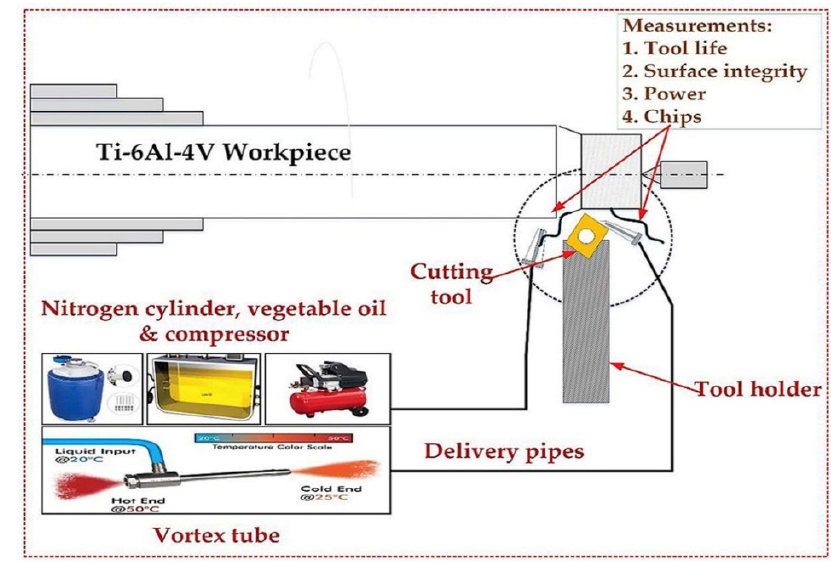
Fig. 23 Mechanism of the performance of hybrid cryo-lubrications in the turning of Ti–6Al–4V alloy in terms of tool wear, surface roughness, and micro hardness [121]. Reproduced with permission from Ref. [121], © Elsevier Ltd.,